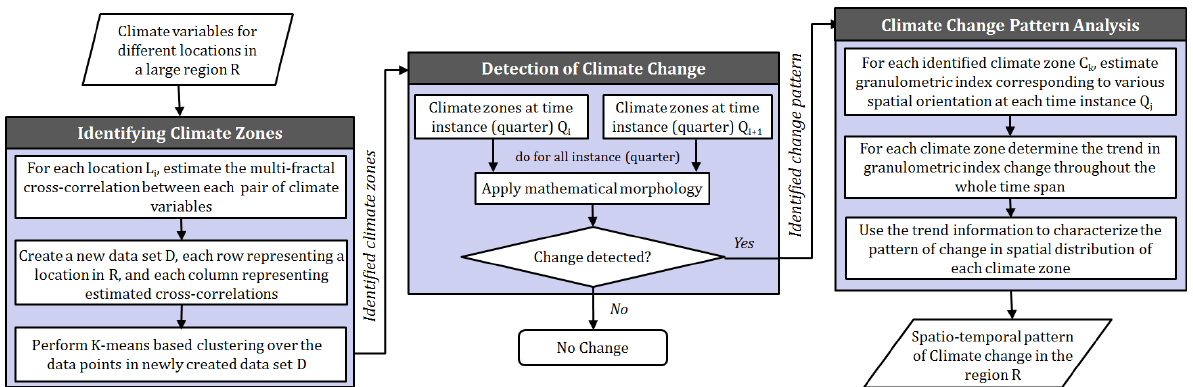
Figure 2. Flow diagram of the proposed approach for regional analysis of spatio-temporal pattern in climate